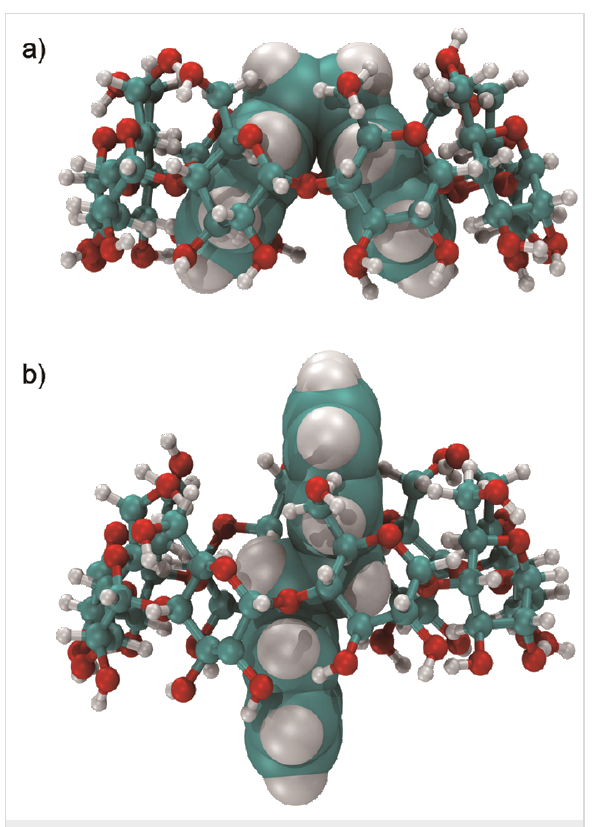
Figure 4: Schematic drawing of the ACE photodimers in γ -CD: a) the syn photodimer and b) the anti photodimer. The rendering was performed with VMD 1.8.7 [37]. Figure 5: Structures of COU